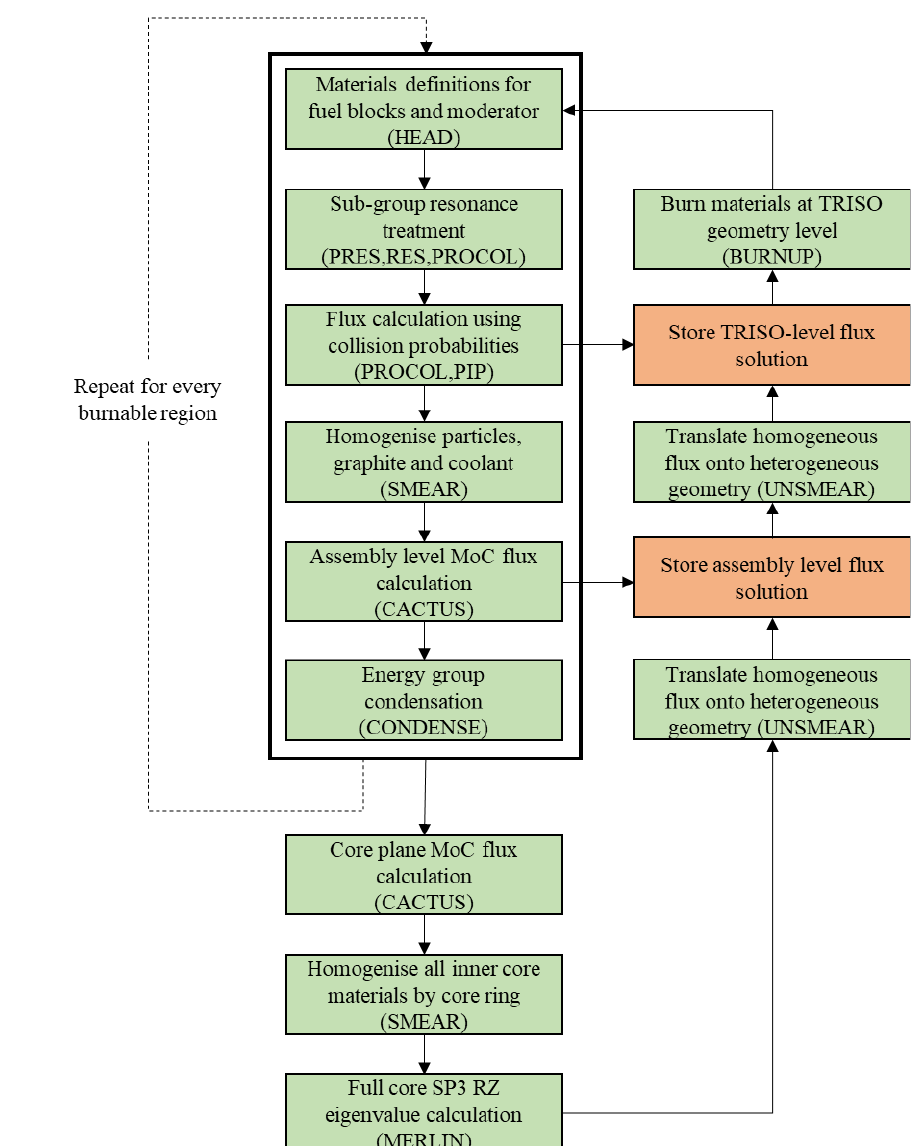
Figure 3: Flow chart for burnup calculations for the more detailed calculation rout. Capitalised words are WIMS11